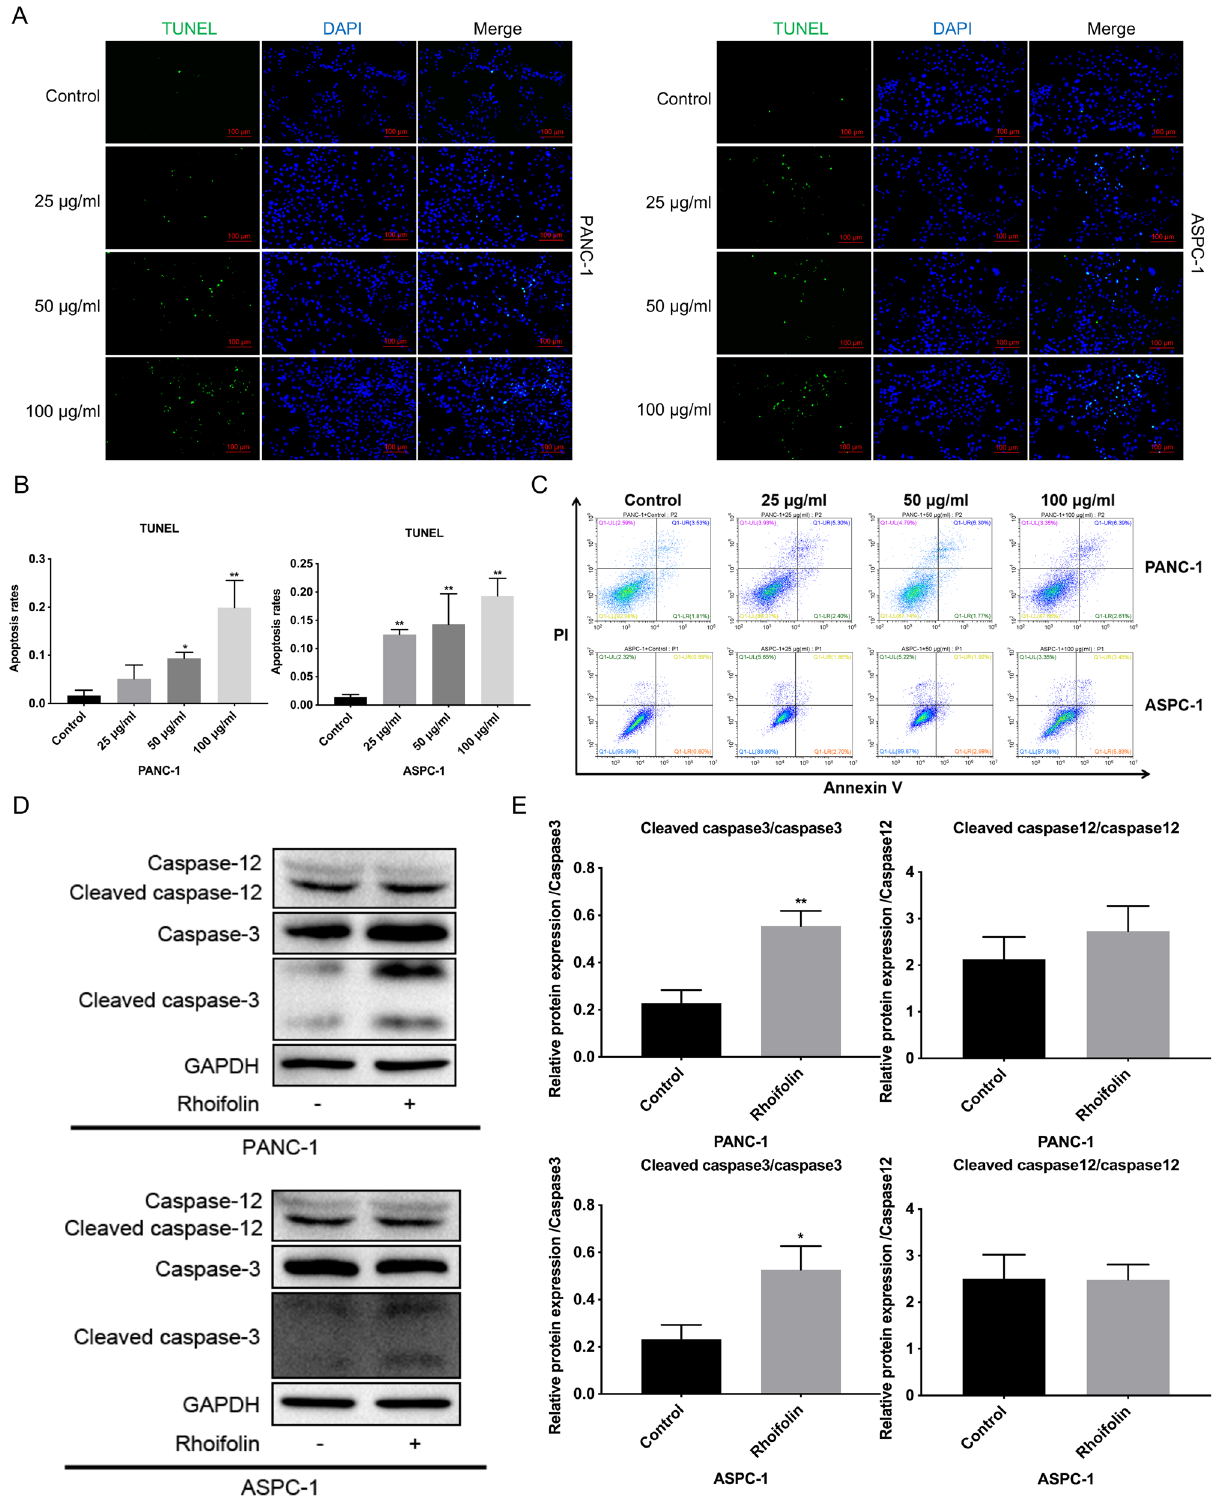
Figure 3. Rhoifolin induced the apoptosis of pancreatic cancer cells. PANC-1 and ASPC-1 cells were addressed with 0, 25, 50, and 100 μg/ml rhoifolin, respectively. (A) TUNEL positive cells were examined using TUNEL staining. (B) The apoptosis rate was calculated based on the results of (A) . ( C) Cell apoptosis was monitored by applying Flow cytometry. (D) Western blotting analysis of caspase-12, Cleaved caspase-12, caspase-3, and Cleaved caspase-3 in the processed cells. (E) The relative comparability of Cleaved caspase-12/caspase-12 and Cleaved caspase-3/caspase-3 was counted on account of the western blotting